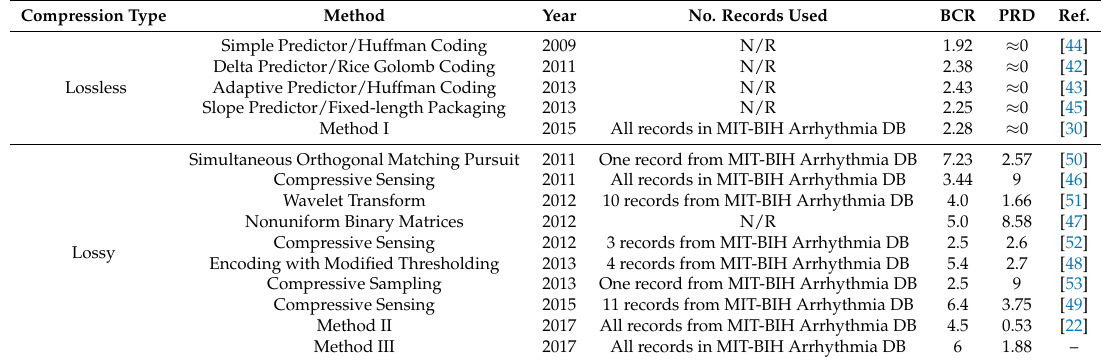
Table 4. Performance comparison of compression methods. BCR stands for bit compression ratio, PRD stands for percentage root-mean-square difference, N/R stands for Not Reported, and the symbol ≈ means nearly